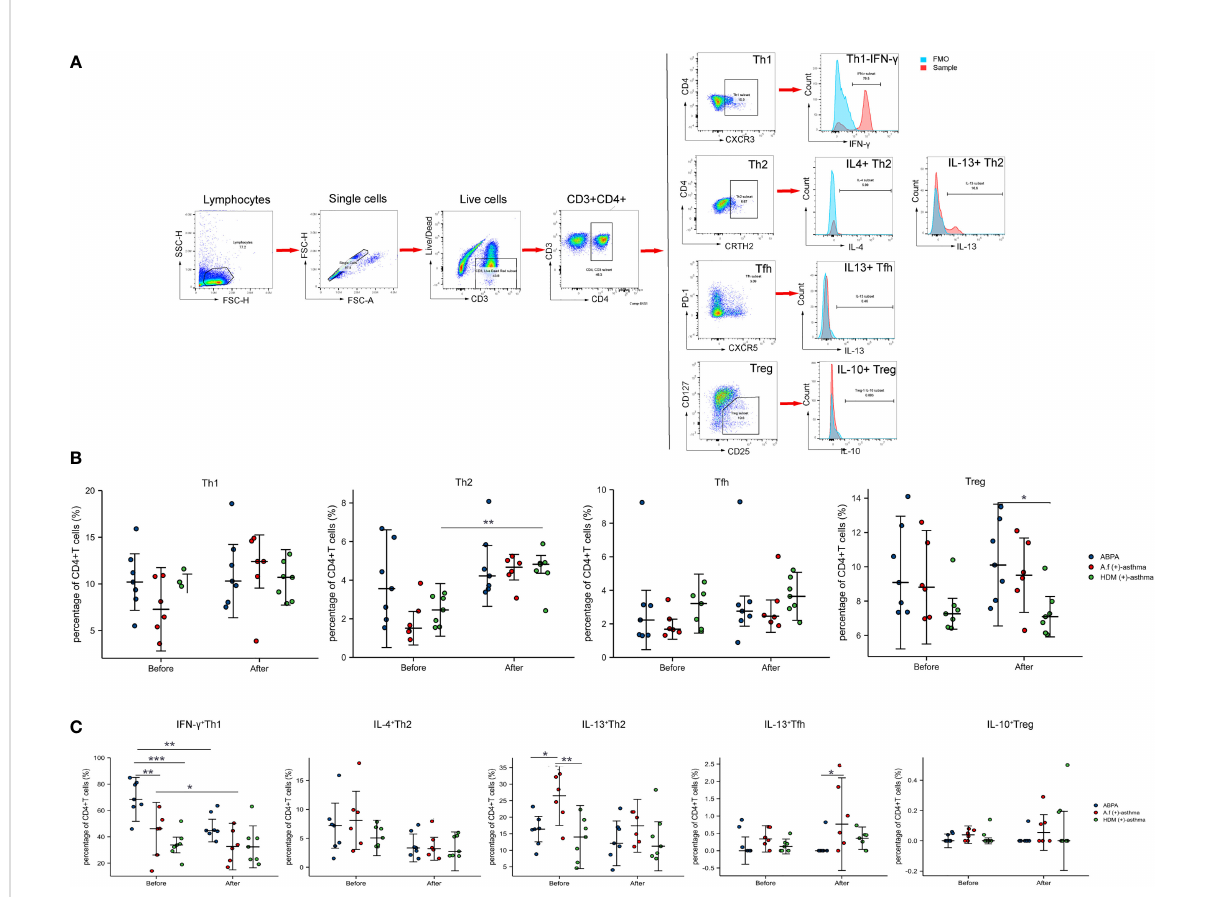
FIGURE 8 CD4 + T-cell subsets and cytokines expression. (A) Manual gating strategy for CD4 + T-cell subsets and representative plots for Th1 (CD3 + CD4 + CXCR3 + ), Th2 (CD3 + CD4 + CRTH2 + ), Tfh (CD3 + CD4 + CXCR5 + PD-1 + ), and Treg (CD3 + CD4 + CD25 + CD127 low/ − ). IFN- g + Th1, IL-4 + Th2, IL-13 + Th2, IL-13 + Tfh, and IL-10 + Treg were representatively exhibited and compared with FMO control. (B) The dot plot fi gures showed CD4 + T-cell subsets; (C) the cytokines of the Th1 (IFN- g ), Th2 (IL-4 and IL-13), Tfh (IL-13), and Treg (IL-10). ABPA, allergic bronchopulmonary aspergillosis; A.f (+) asthma, Aspergillus fumigatus -sensitized asthma; HDM (+) asthma, house dust mite-sensitized asthma; Th1, T helper cells 1; Th2, T helper cells 2; Tfh, follicular helper T cells; Treg, regulatory T cells; IFN- g , interferon g ; IL-4, interleukin 4; IL-13, interleukin 13; IL-10, interleukin 10. *p<0.05, **p<0.01;